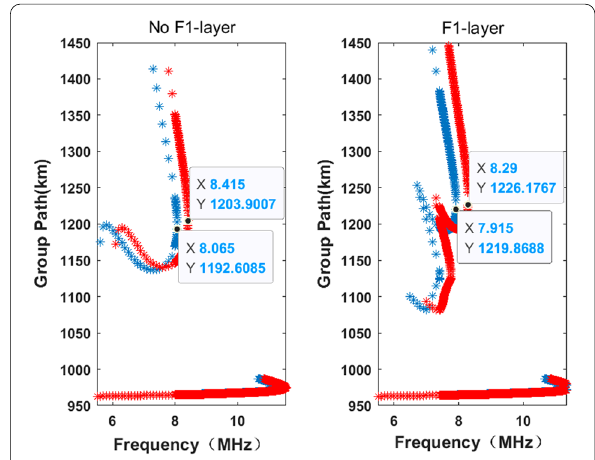
Fig. 12 Synthesized oblique ionograms with and without